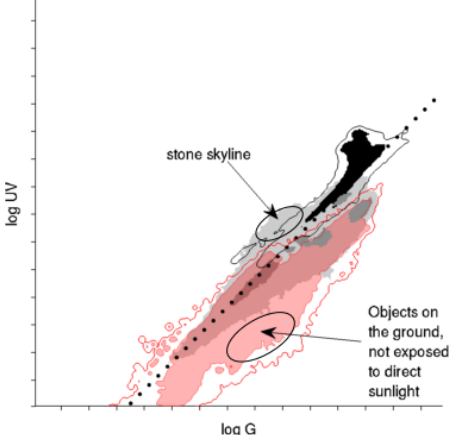
Figure 14. Pooled plot of all ground object databases (red). The wide variety of different objects and lighting conditions (partly in the same image) does not allow a unique distinction of the lighting conditions as in Figure 13. For comparison, the pooled data from Figure 10 ( X 8–19 ) are shown. The highlighted areas (ellipses) show where differences between the object and skyline databases